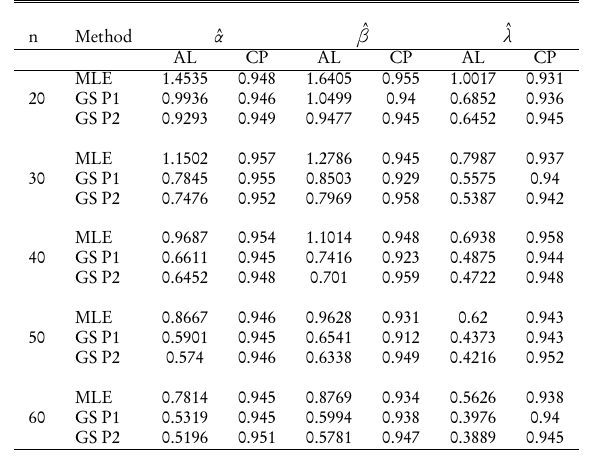
The average length (AL) and the coverage probability (CP) of 95% asymptotic confidence / HPD credible intervals of parameters when α = 2, β = 1.5, λ = 1.